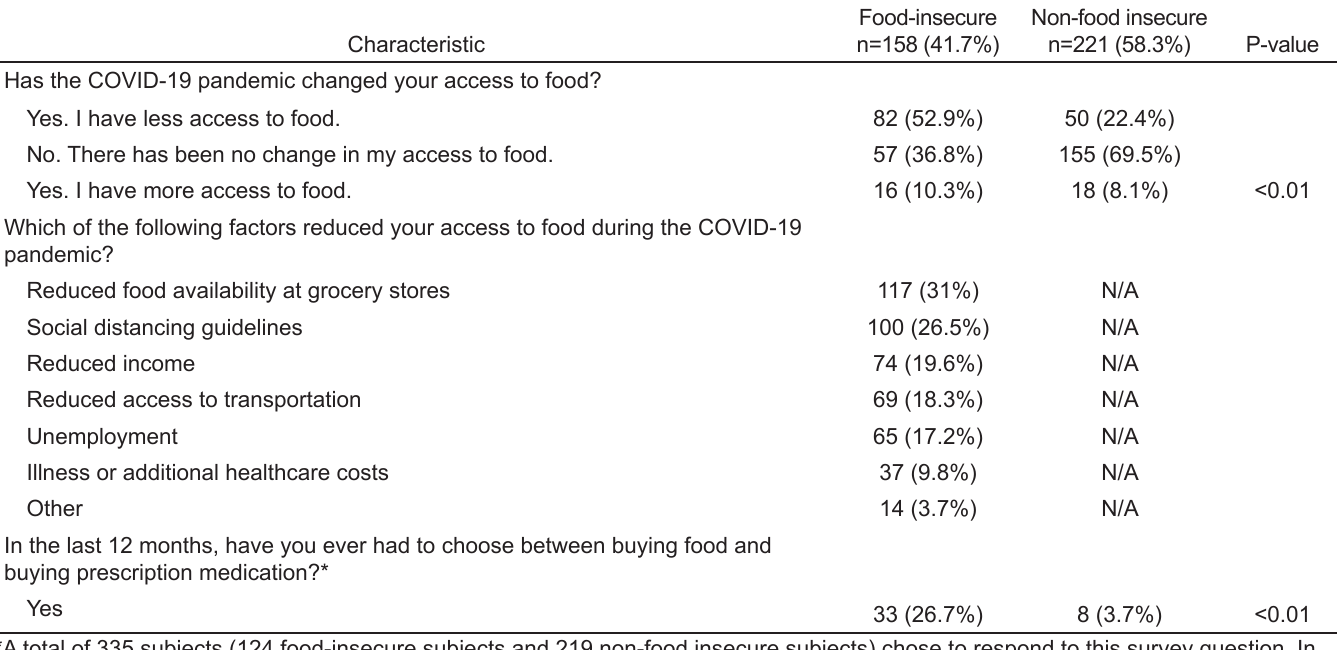
Table 2. Survey answers describing the influence of the COVID-19 pandemic on participants’ access to food.